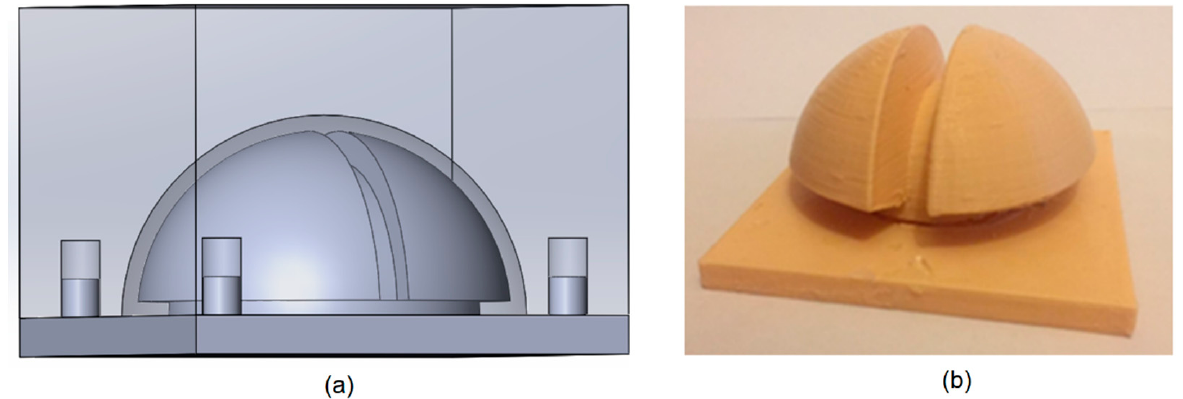
Figure 3. ( a ) SolidWorks model of the shell mold. ( b ) 3D printed mold used to fabricate two similar halves of the silicone shell.